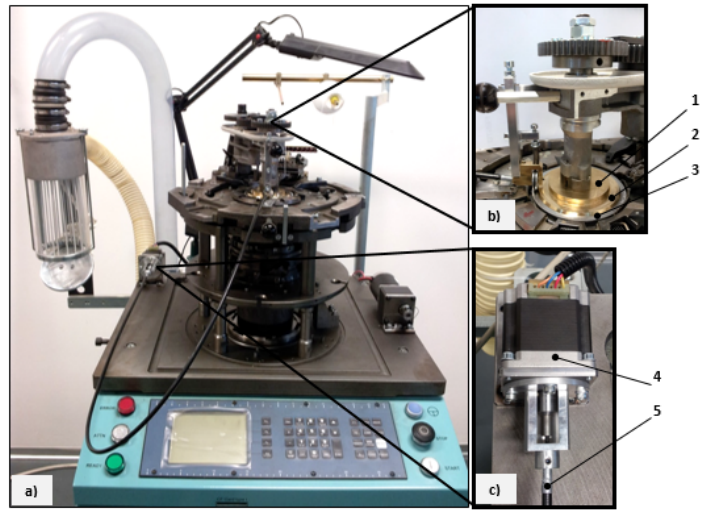
Figure 20. Installation of the individual roller cutter drive system into the Ange 18.1 small diameter knitting machine and detailed display of the basic nodes of the individual roller cutter drive system.